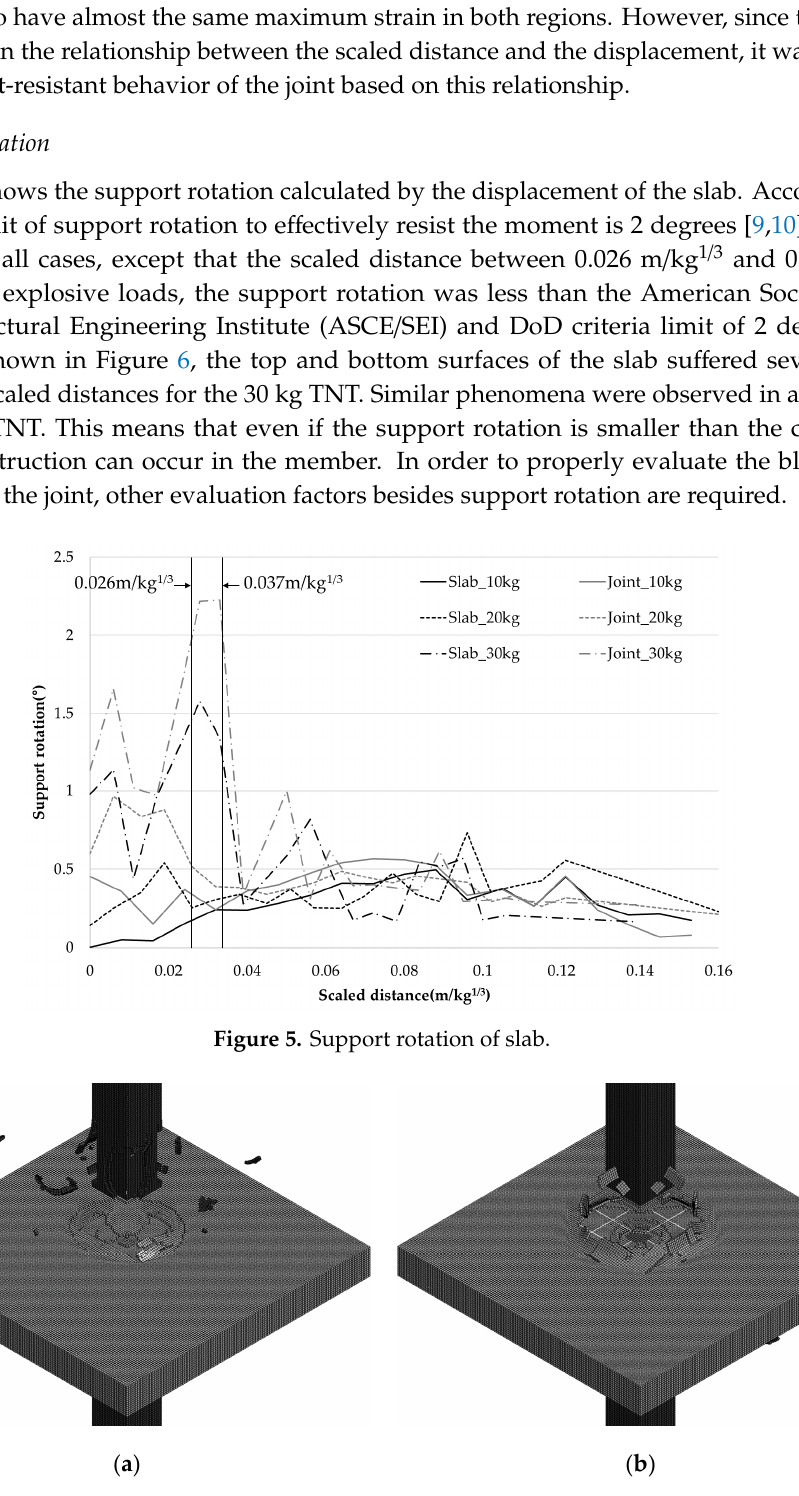
Figure 6. Failure shapes (30 kg, Z = 0.067 m/kg 1/3 ); ( a ) Top surface; ( b ) Bottom surface